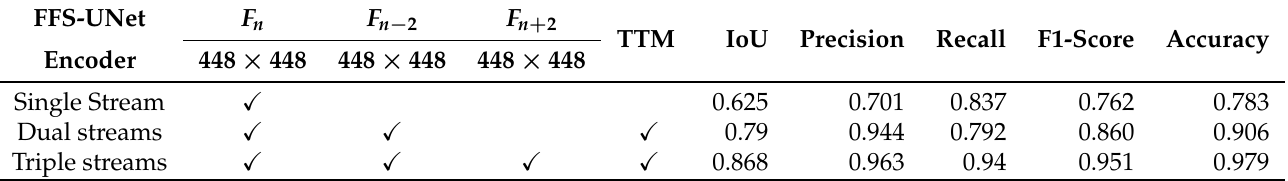
Table 2. Experimental outcome on the effect of the parallel encoder with TTM.